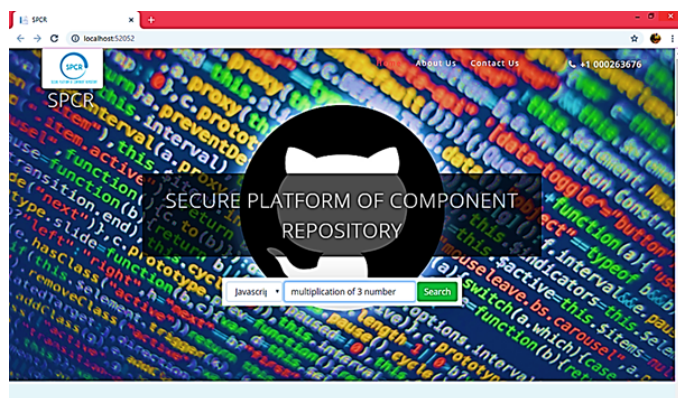
Figure 9. Select Language.